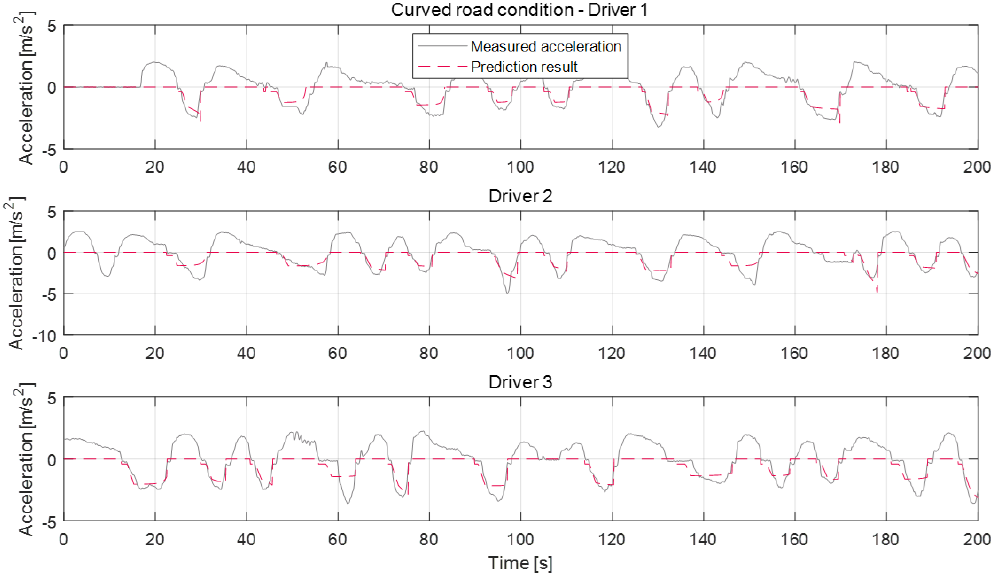
Figure 17. Deceleration prediction results on curved road